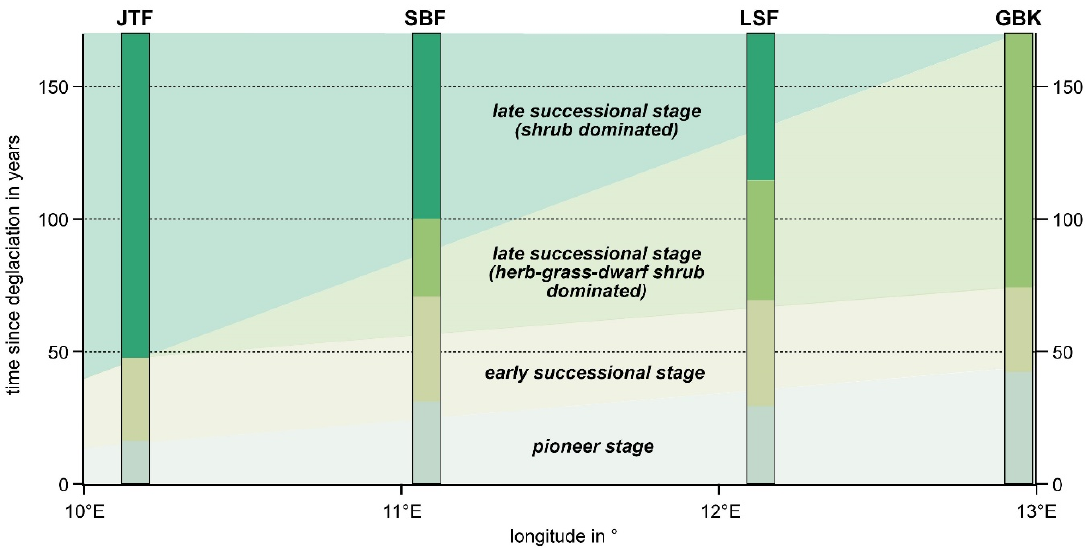
Figure 8. Gradual shift of successional trajectories from West to East within the Eastern Central Alps as revealed by the four glacier forelands studied.